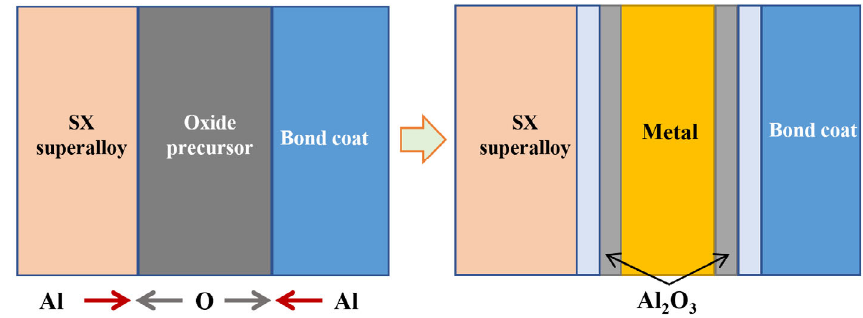
Fig. 45 Schematic showing the formation of active DB with sandwich structure.